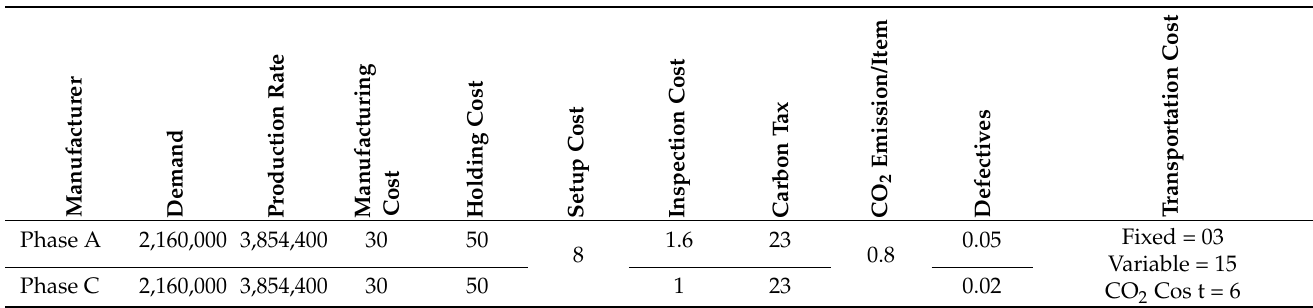
Table 5. Manufacturing data for phase A and phase C.